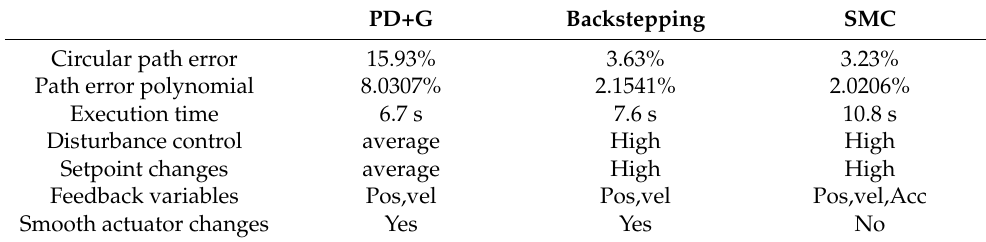
Table 4. Comparison of nonlinear controllers against polynomial trajectories. PD+G Backstepping SMC Circular path error 15.93% 3.63% Path error